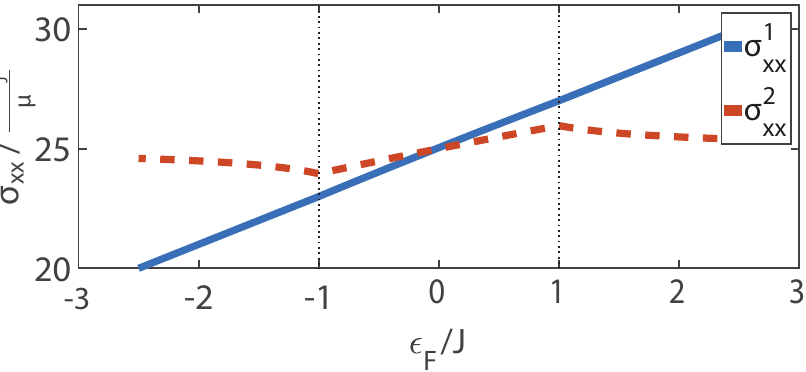
Figure 2. Longitudinal conductivities σ 1 xx and σ 2 xx vs. the Fermi energy (cid:101) F , where α k J / J = 5, the solid line is σ 1 xx , and the dashed line is σ 2 xx